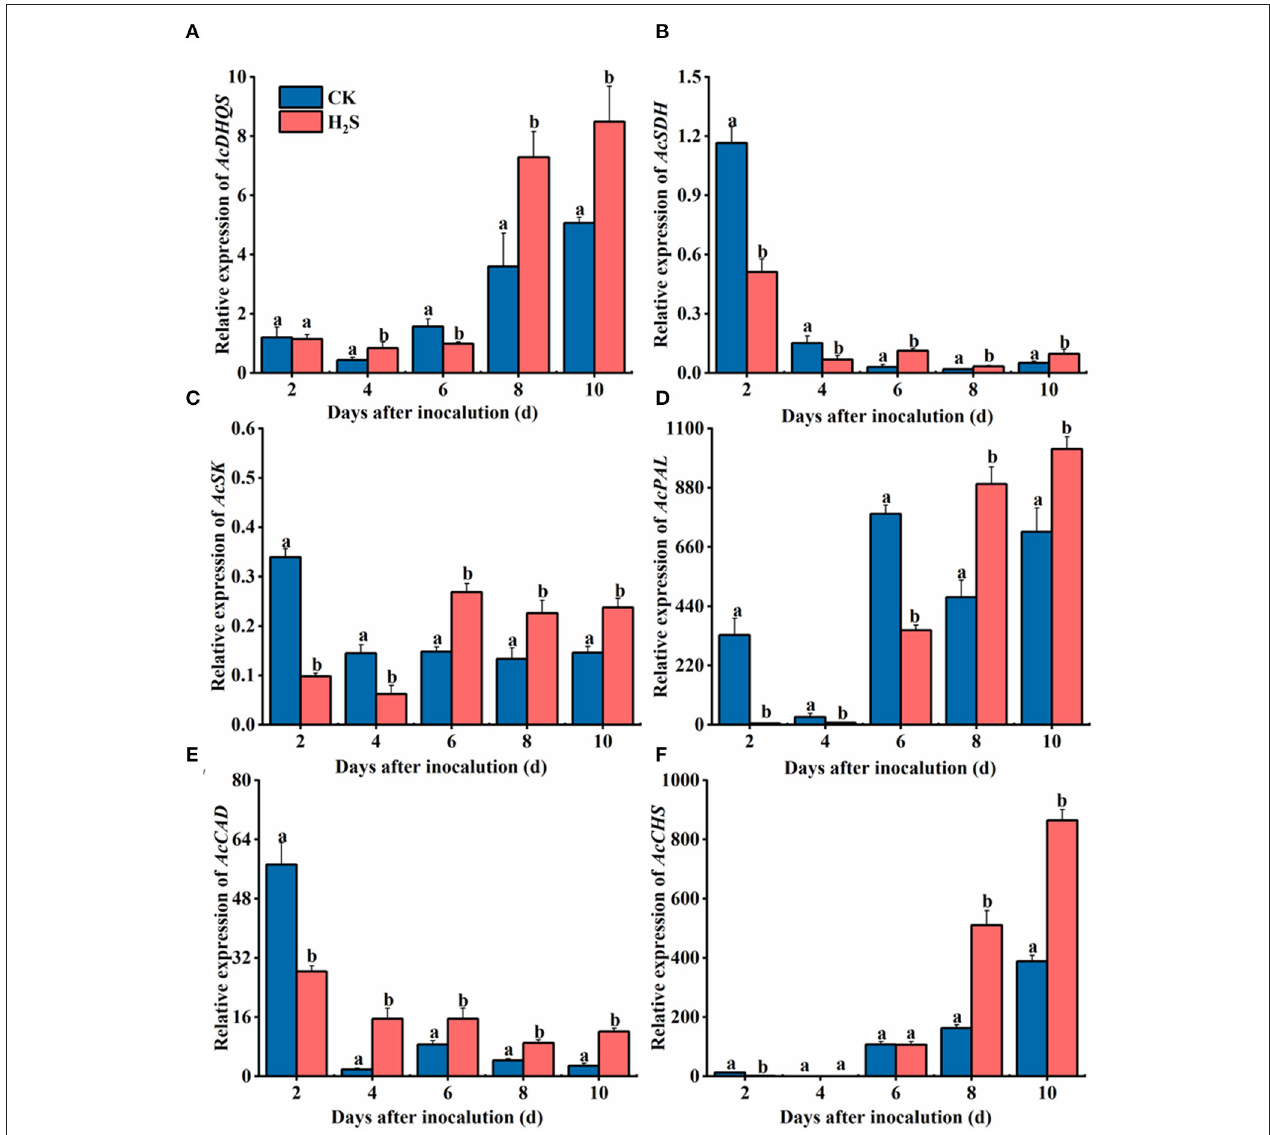
FIGURE 4 | Expressions of AcDHQS (A) , AcSDH (B) , AcSK (C) , AcPAL (D) , AcCAD (E) , and AcCHS (F) genes in kiwifruit with inoculation of B. dothidea after the H 2 S treatment during storage at 25 ◦ C. Actin was used as an internal standard for each gene. Vertical bars represent the standard errors. Letters indicate significant differences ( P <